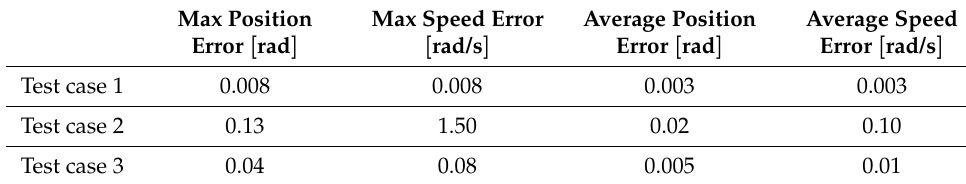
Figure 20. Test case 3, Mode III. The error between simulation and real system. Joint rotations ( left ) and joint speeds ( right ). Table 2. Summary of results: comparison between simulated and real joint data.